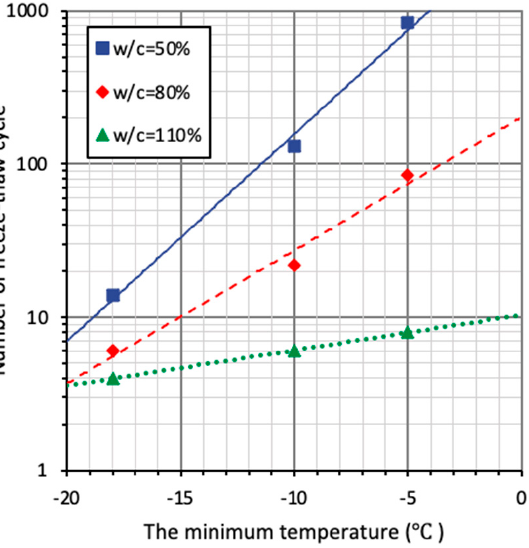
Figure 22. Number of FTC when RDEM drops to 60% for different lowest temperatures.